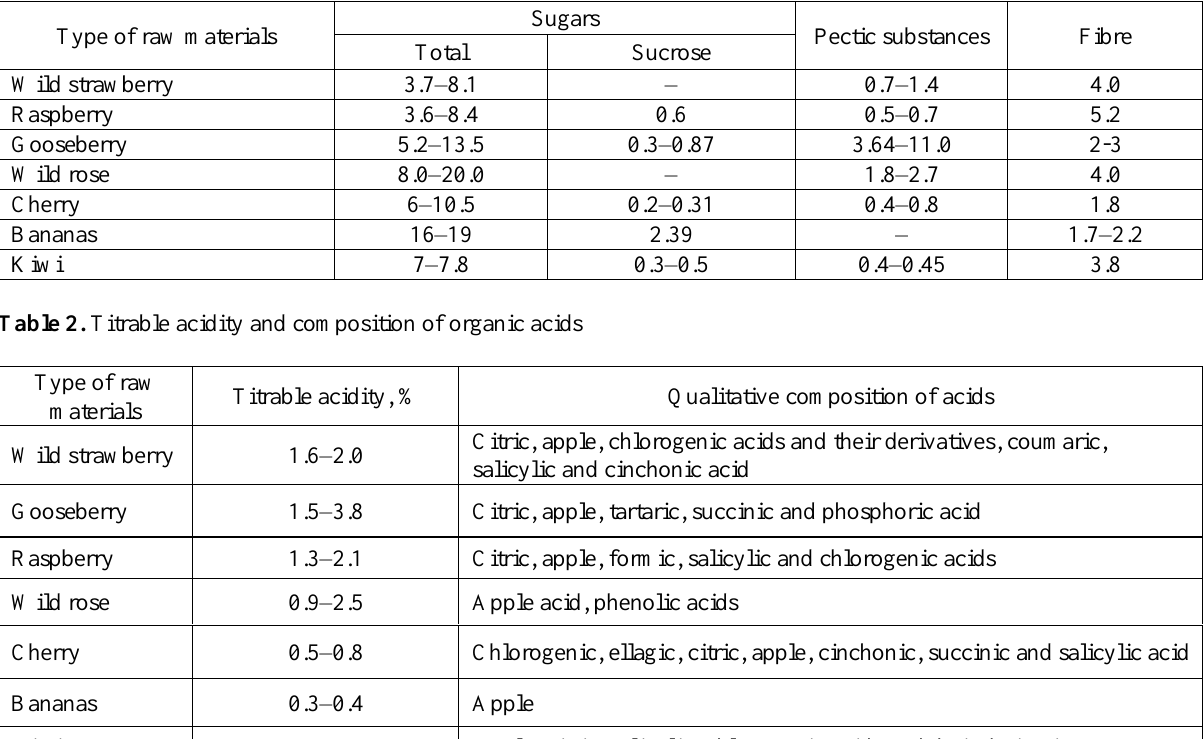
Table 1. Carbohydrate composition of fruits and berries, %